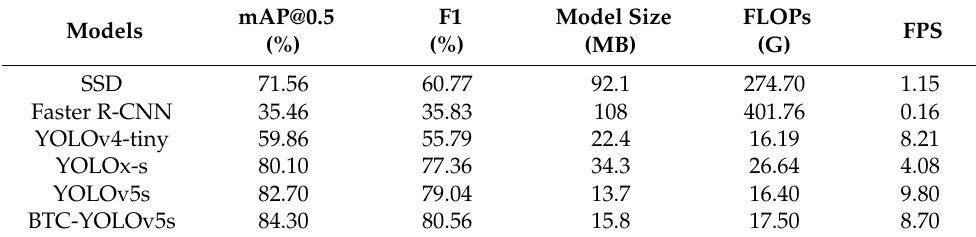
Table 6. Performance comparison of mainstream detection models.